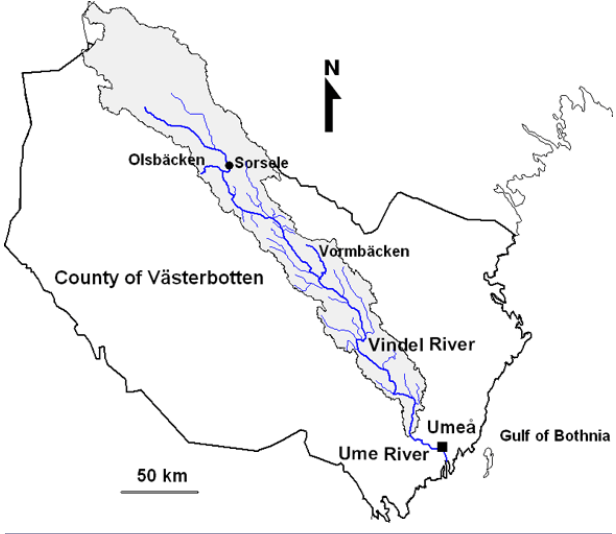
Fig. 1 . The Vindel river catchment in northern